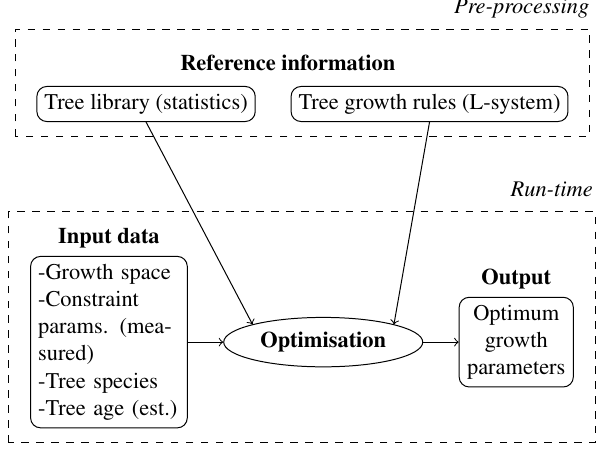
Figure 15. Procedural modeling